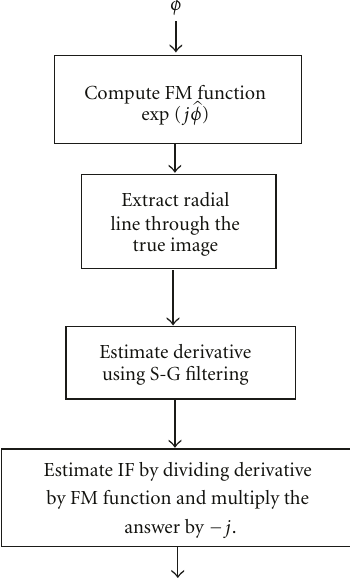
Figure 5: Instantaneous frequency magnitude estimation along the radial direction. For robust estimation, we use an S-G filter to estimate the derivative of the FM function. This is used in estimating the instantaneous frequency (IF) (see (9) for